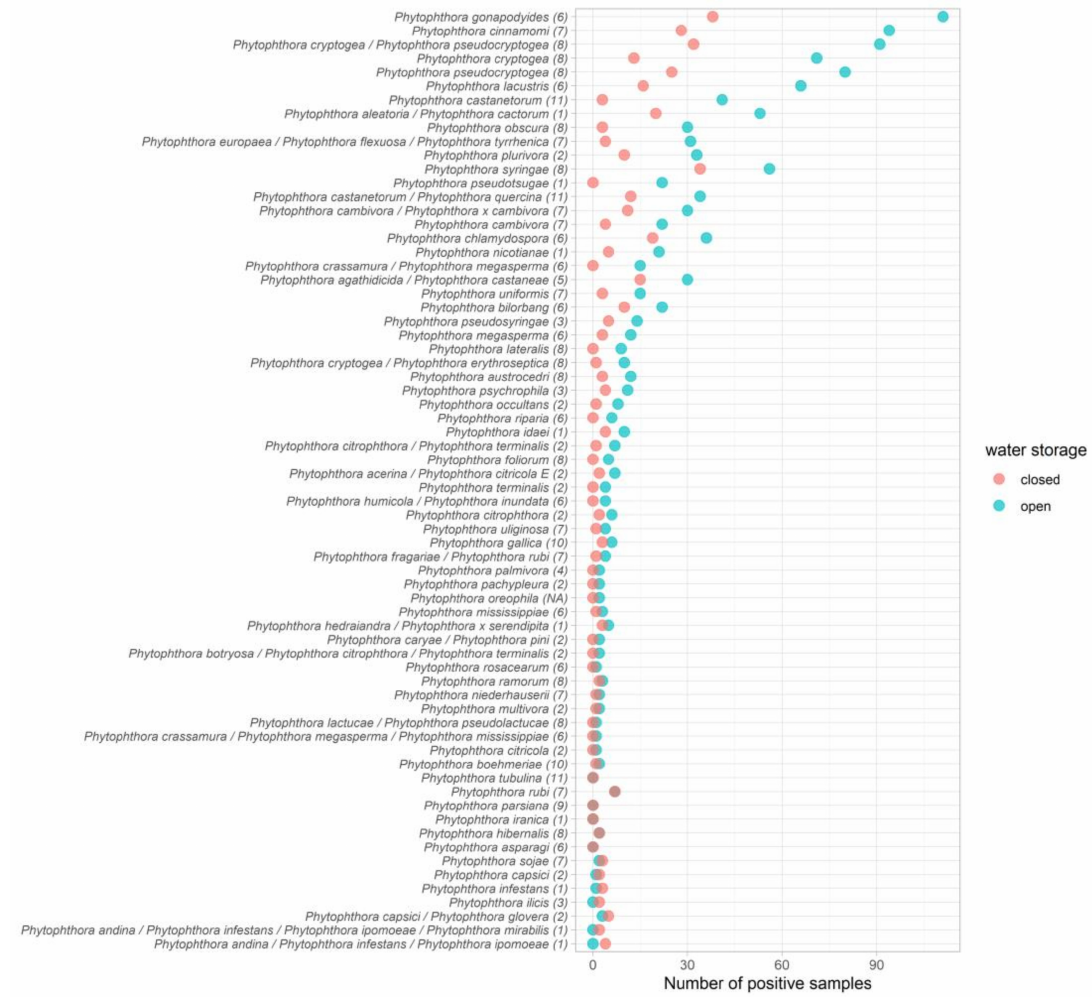
Figure 6. Number of samples testing positive for each Phytophthora species at nurseries using open versus closed water sources. Taxonomic clade is presented in brackets after each species name. Data represent samples collected from the fifteen nurseries sampled in the fine-scale